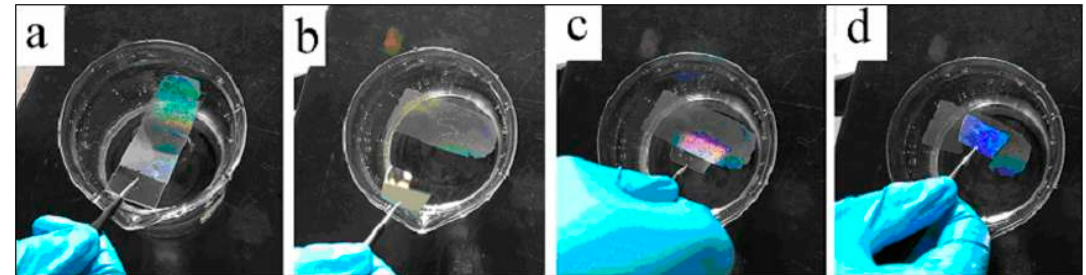
Figure 2. The photos of the PS colloidal monolayer transfer from a glass slide to another substrate. ( a ): A glass slide covered with PS colloidal monolayer on a slant is slowly put into the distilled water in a cup, and the monolayer is peeling off from the glass and floats on the water’s surface. ( b ): The colloidal monolayer peels off completely from the glass and floats on the surface of water with good integrity. ( c , d ): The floating monolayer is being picked up with another substrate (a silicon wafer).